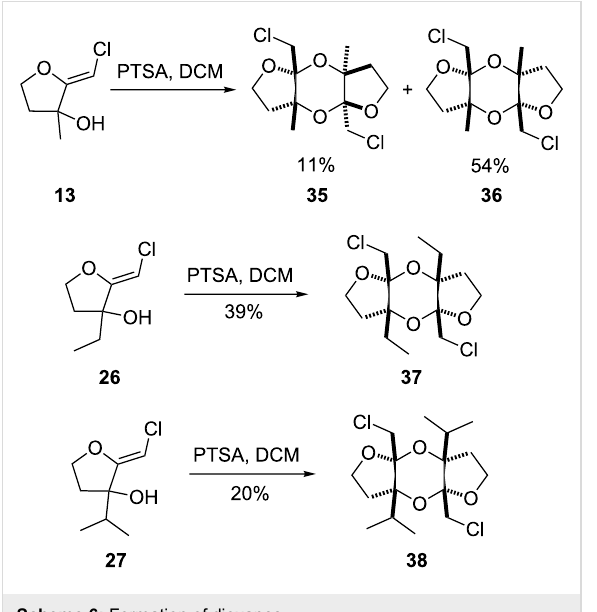
Scheme 6: Formation of dioxanes.